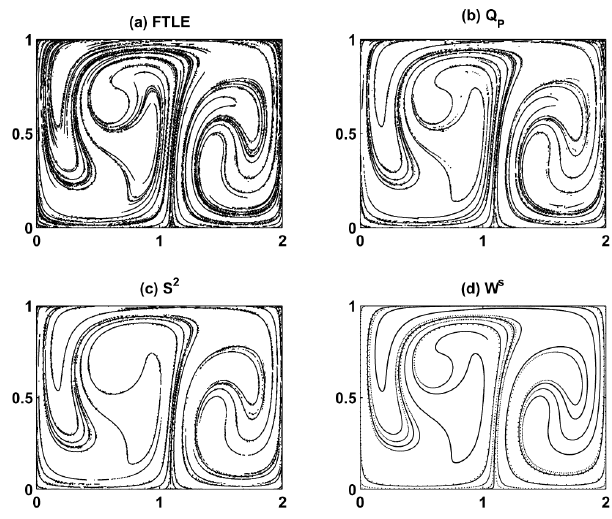
Fig. 2. Ridge extraction from (a) FTLE σ , (b) Okubo–Weiss Q P , and (c) total strain fields. The ridge detection algorithm used values larger than 50% of maximum for FTLE and 20% for OW and total strain. (d) The stable manifold W S (x 0 ,y 0 ) of the moving instan- taneous saddle point around (x 0 ,y 0 ) = ( 1 , 0 ) after the integration time τ = 3 T (see Appendix B). Set of parameters as in Fig.